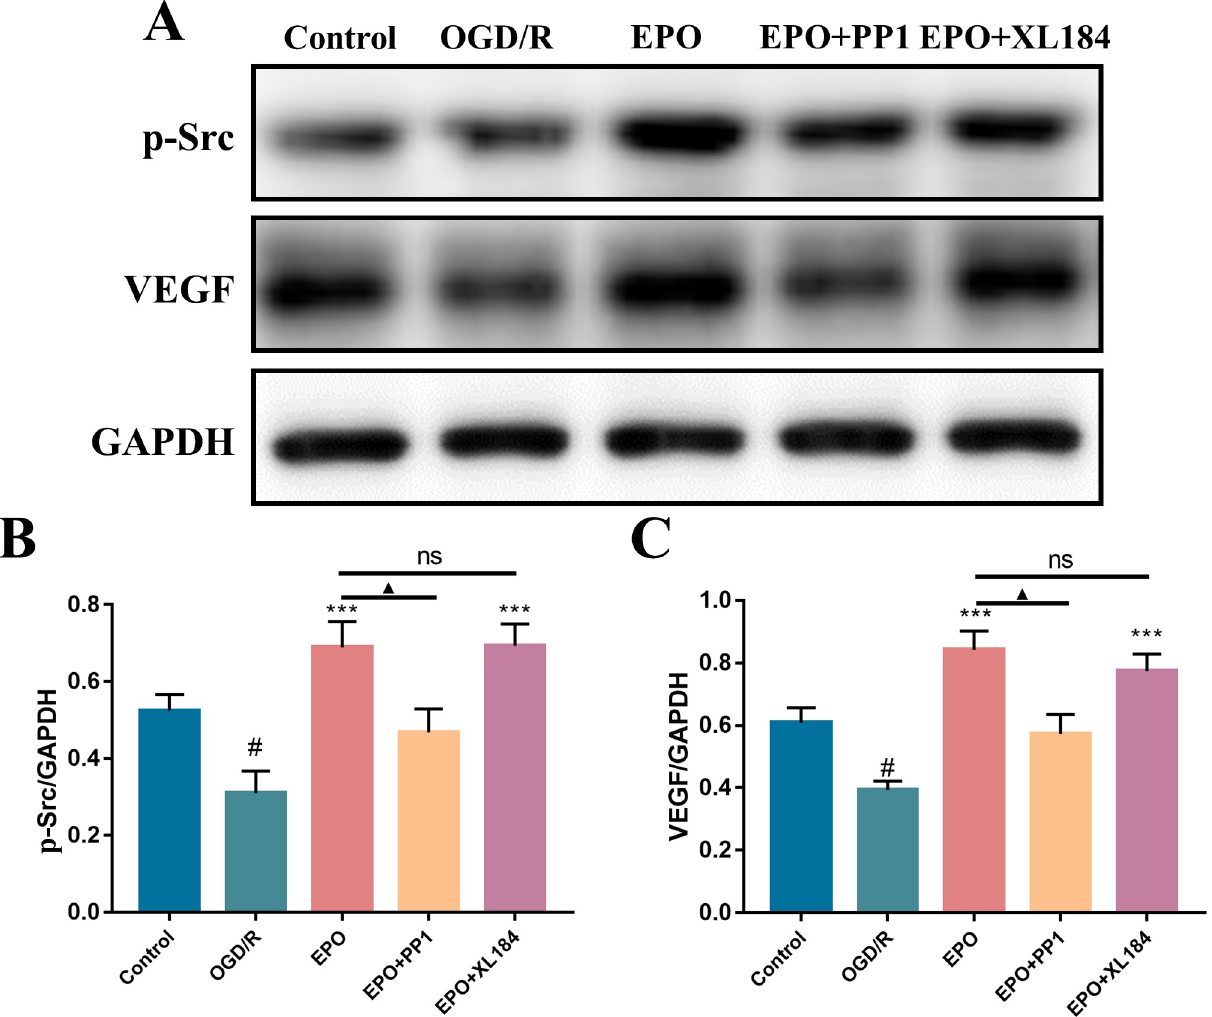
Fig 5. The recombinant EPO protein increased the expression of VEGF and p-Src in bEnd.3 cells after OGD/R. (A) Representative expression of the VEGF and p-Src in the control, OGD/R, EPO, EPO + PP1 and EPO + XL184 groups. (B) Quantification of the expression level of VEGF and p-Src proteins (n = 5). Data were expressed as mean ± SEM. # P < 0.05 vs. control group; ��� P < 0.001 vs. OGD/G